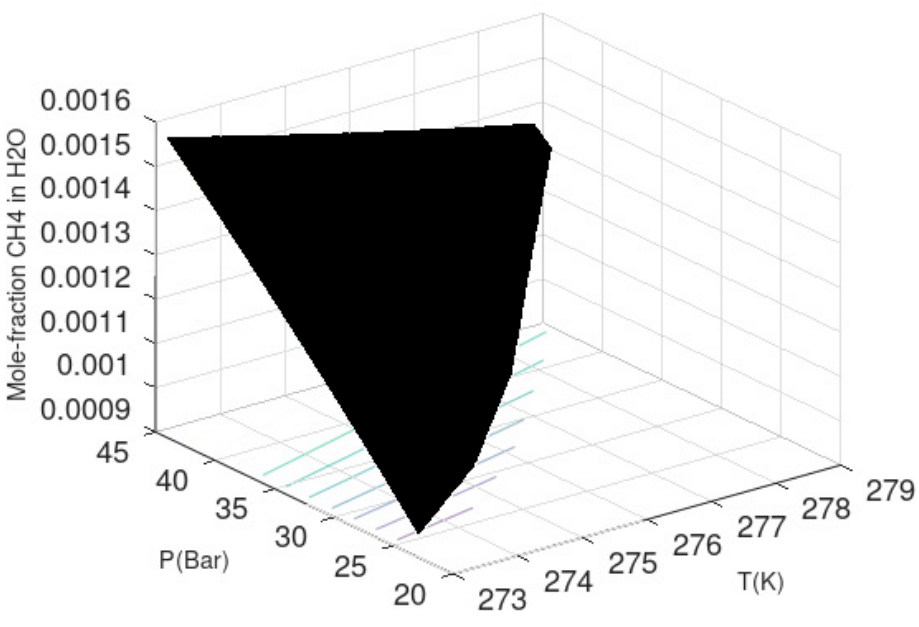
Figure 5. Liquid water solubility of methane.